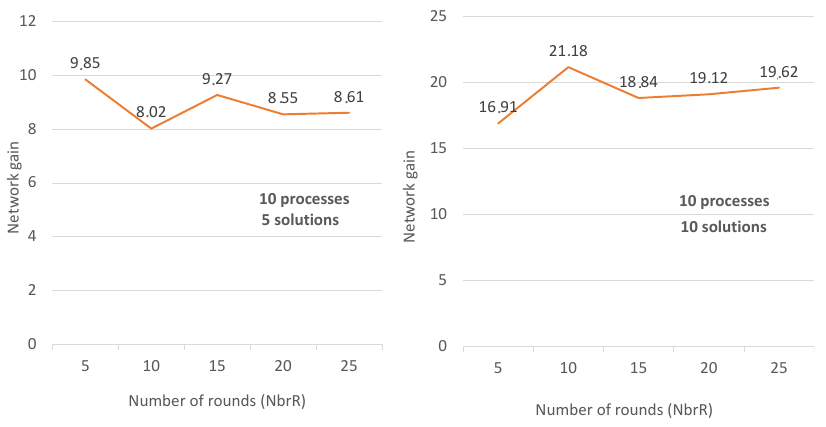
Figure 5. The influence of NbrR, case B.